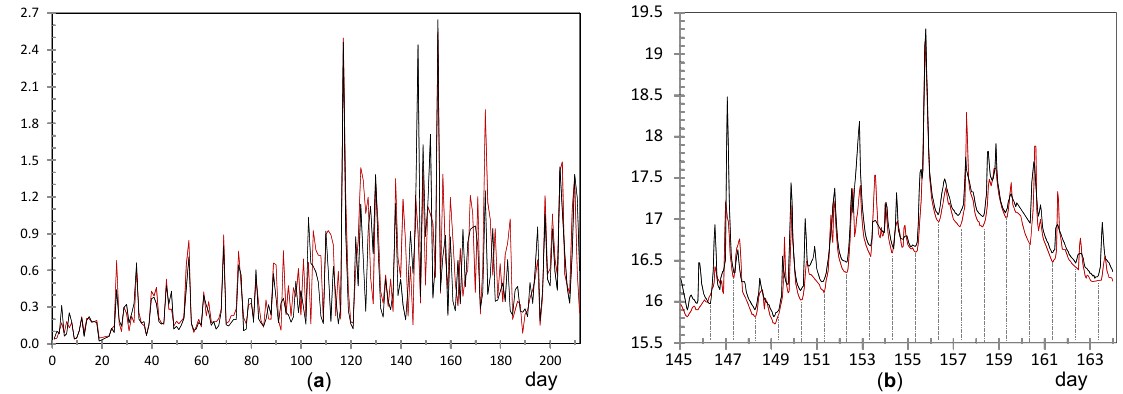
Figure 13. Evolution of temperature ( ° C) for nodes RE5 (black trajectories) and RE6 (brown): ( a ) time series of daily ranges for the 212 days, ( b ) time series of hourly values from day 145 (23 December) up to day 163 (10 January 2018).